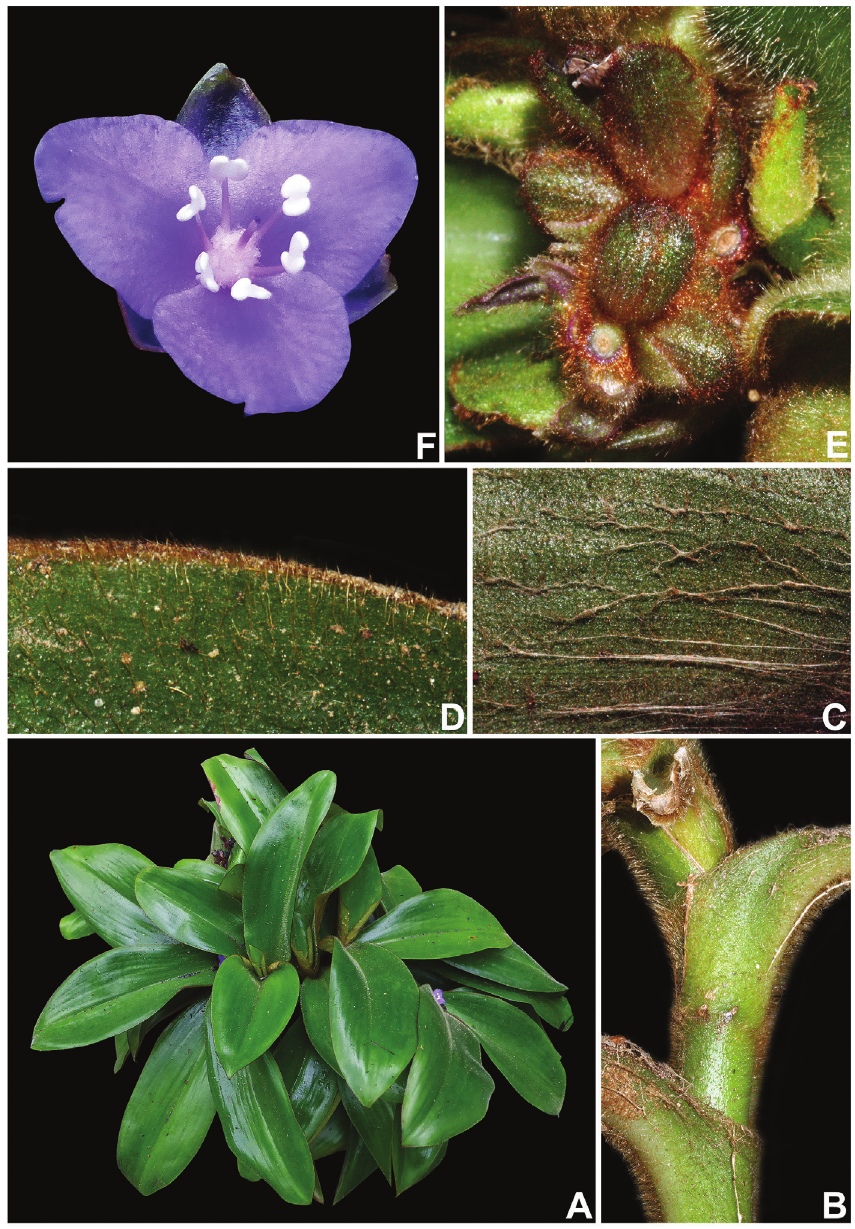
Figure 7. Siderasis almeidae M.Pell. & Faden. A habit, showing a fertile rosette B detail of the elon- gated aerial stem, showing the rusty internodes and leaf-sheaths C detail of the lanate indumentum on the abaxial side of the leaf blade D detail of the hispid indumentum on the adaxial side of the leaf blade E detail of the inflorescence, showing the contracted cincinnus and some floral buds F front view of a flower, showing the fleshy and internally purple sepals, and the lanate ovary. Photographs A, F by M.A.N. Coelho, remaining photographs by M.O.O.